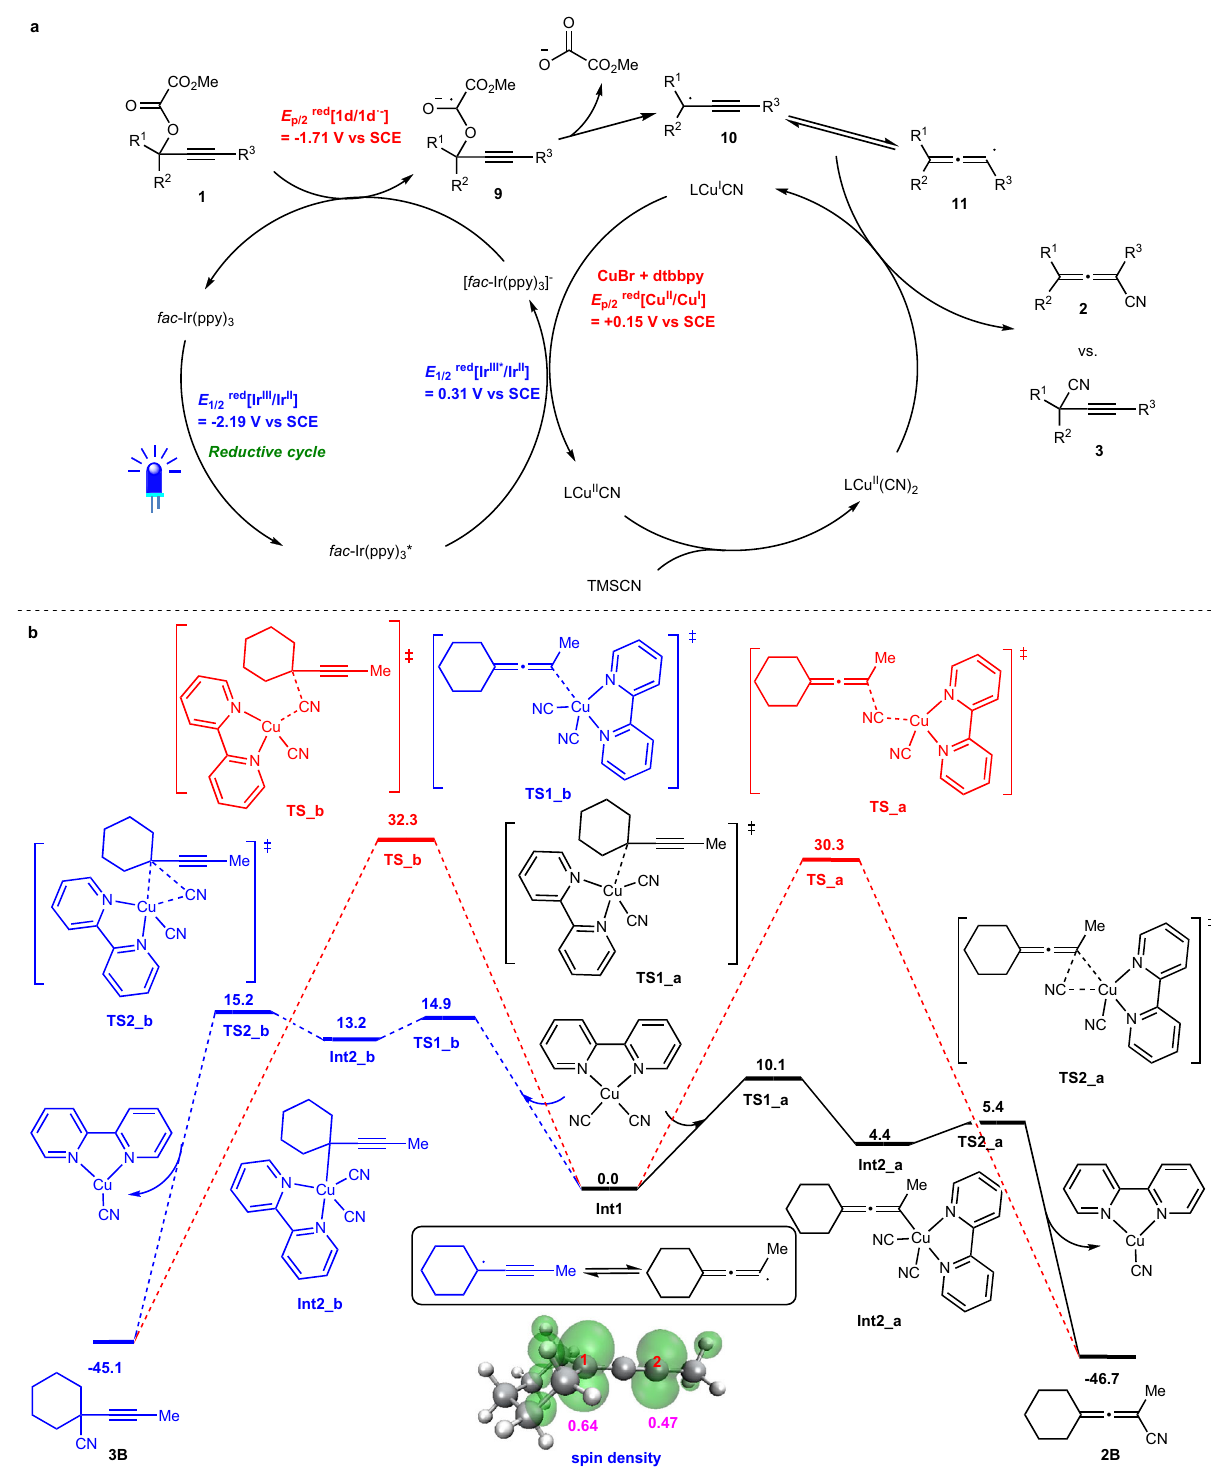
Fig. 6 Possible mechanism. a Proposed mechanism via reductive quenching cycle. b Free energy pro fi les calculated for the reaction of L4 Cu II (CN) 2 with Int1 . Relative free energies are given in